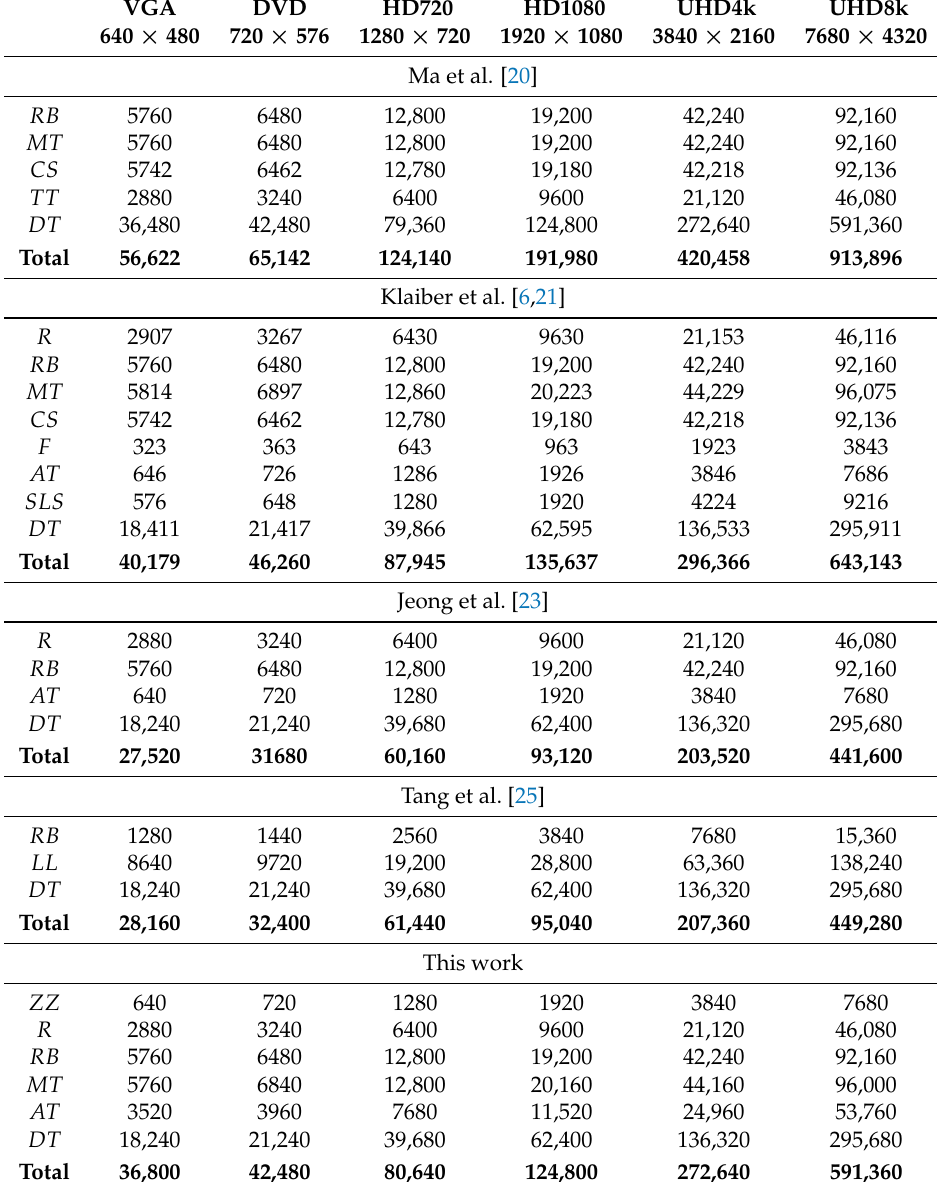
Table 2. Comparison of memory requirements of all data structures of the examined CCA architectures for different image sizes from VGA to